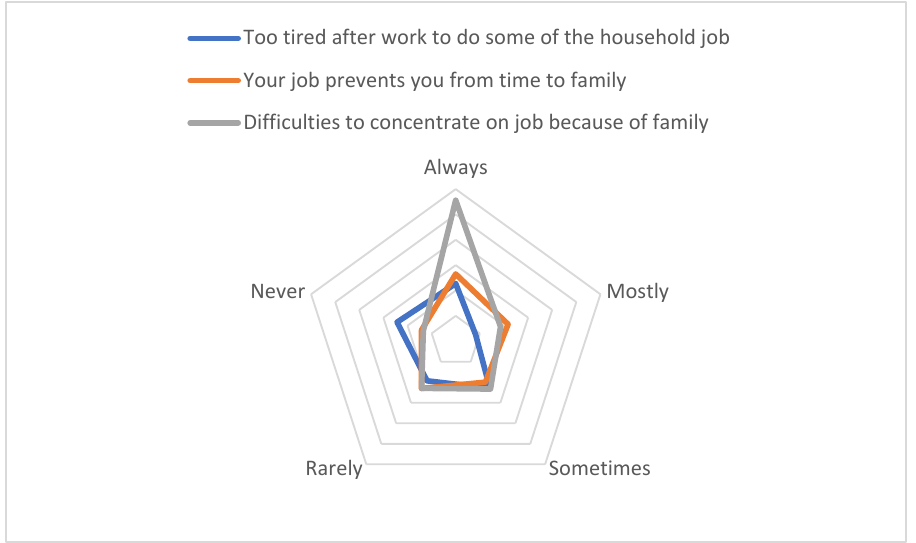
Figure 2. Male distance between life satisfaction and happiness. Source: Own elaboration based on Eurofound data.